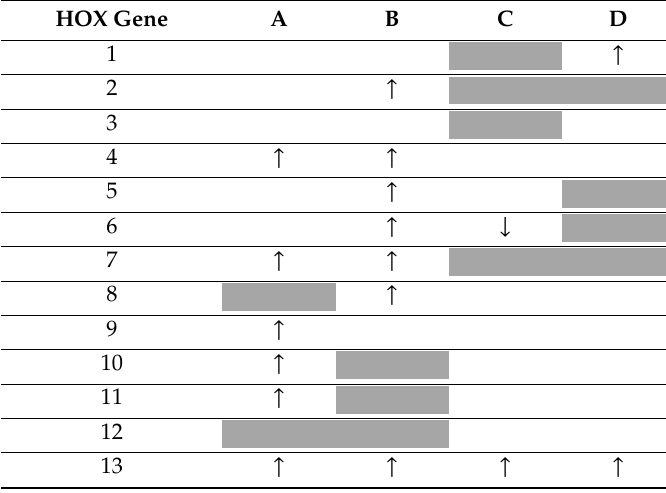
Table 1. HOX gene expression. Table 1 shows the 39 HOX genes and indicates which are commonly over or under expressed in ovarian cancer cell lines or tissues relative to normal ovarian surface epithelium. Grey boxes are HOX genes that do not exist. ( ↑ = overexpressed, ↓ = underexpressed). HOX Gene A B C